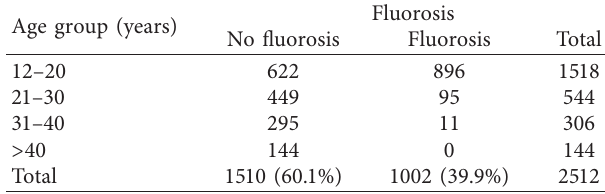
Table 1: Incidence of fluorosis grouped by patient age.